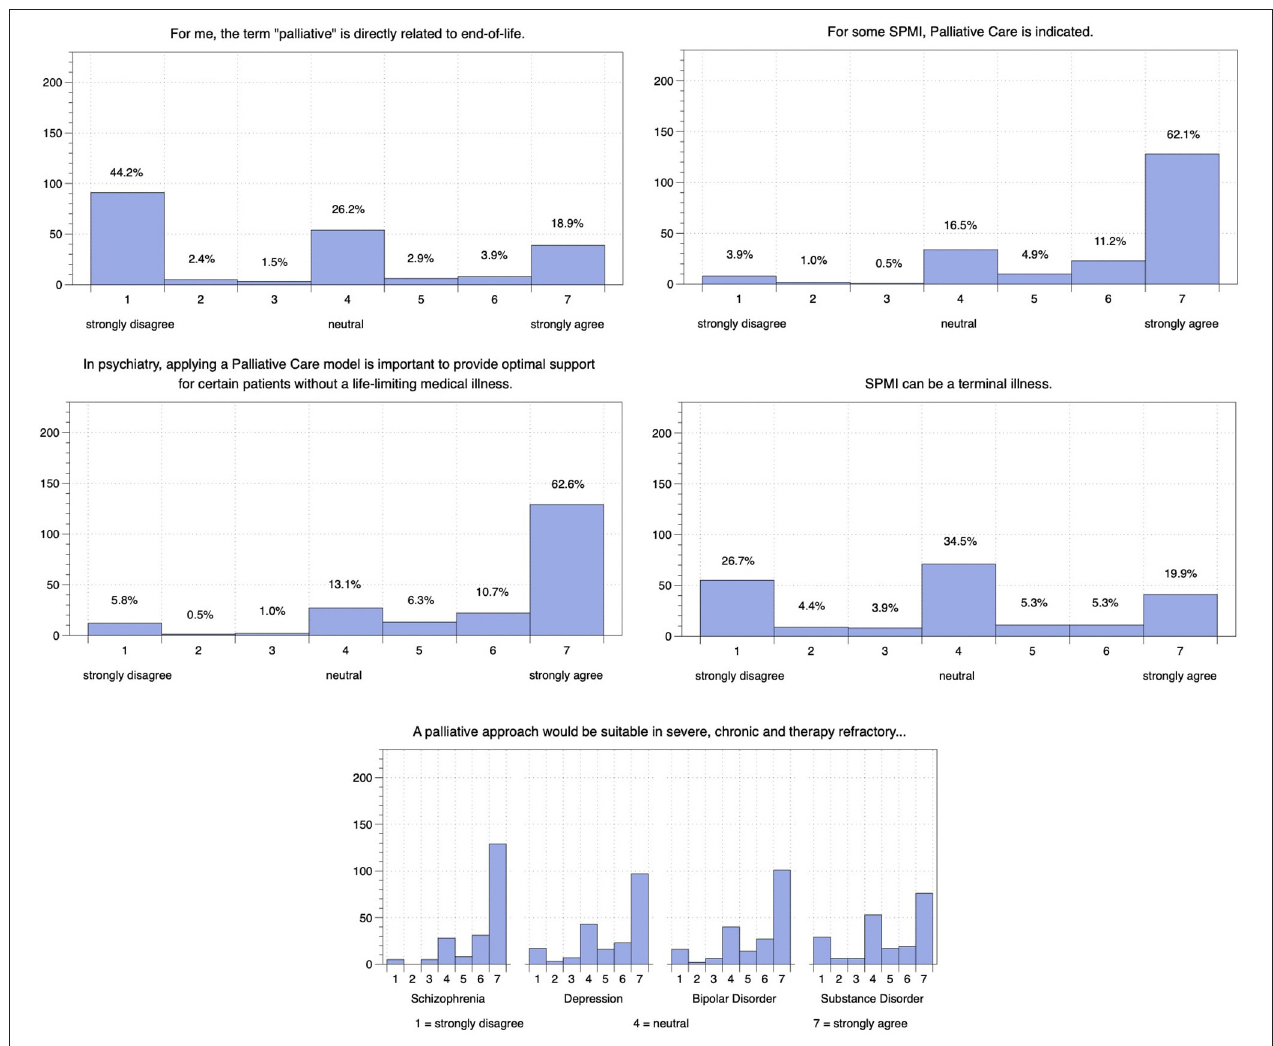
FIGURE 2 | Indian psychiatrists’ attitudes on palliative psychiatry and its use in patients with different